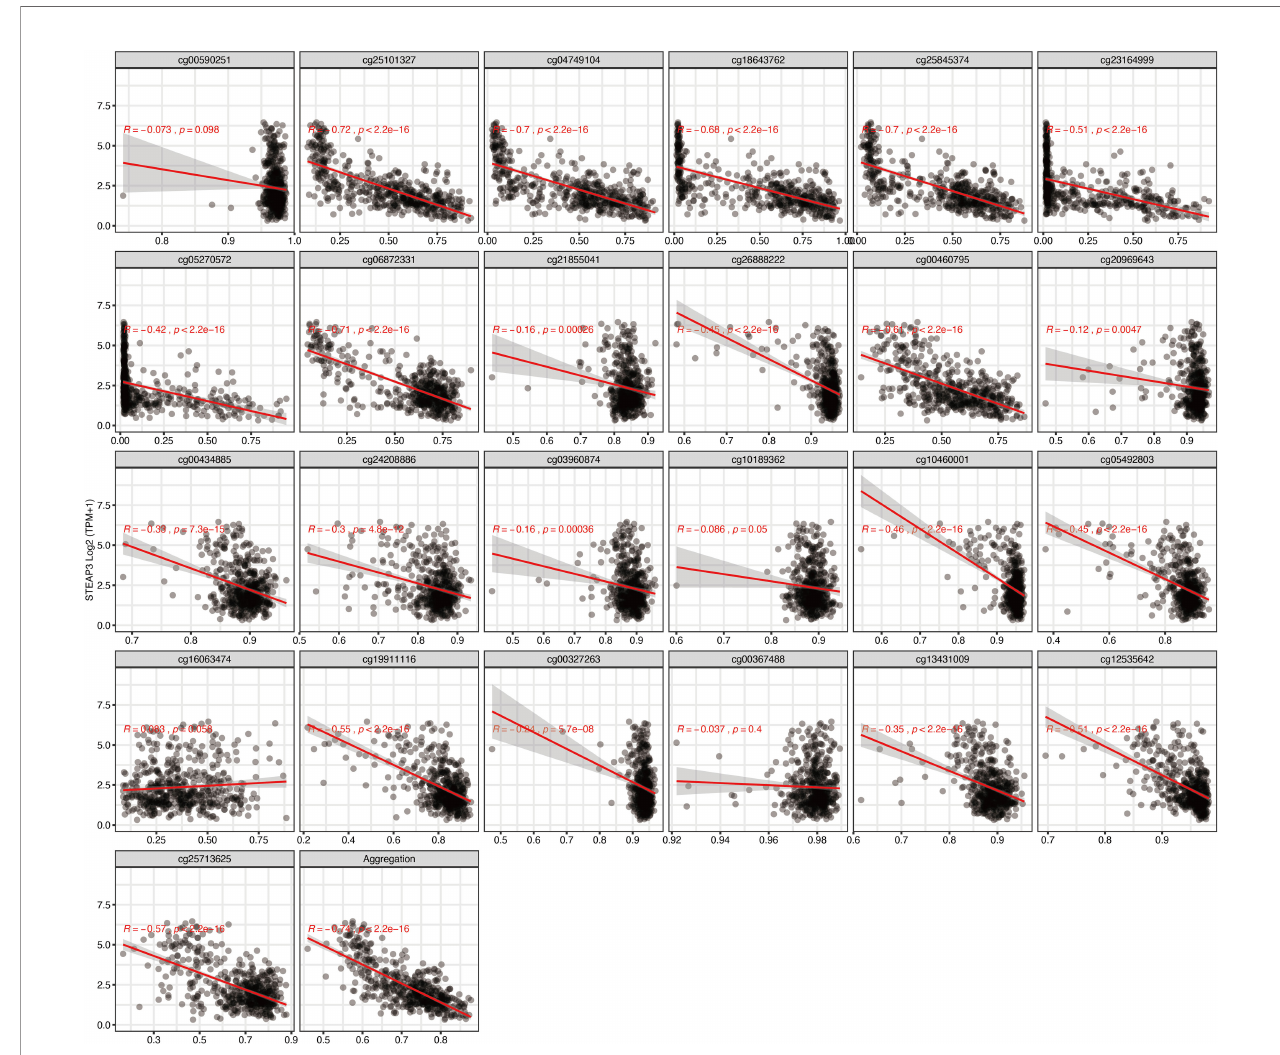
FIGURE 4 | Regression analysis involving each speci fi c CpG site and aggregated levels, and the expression of STEAP3 in the whole dataset from